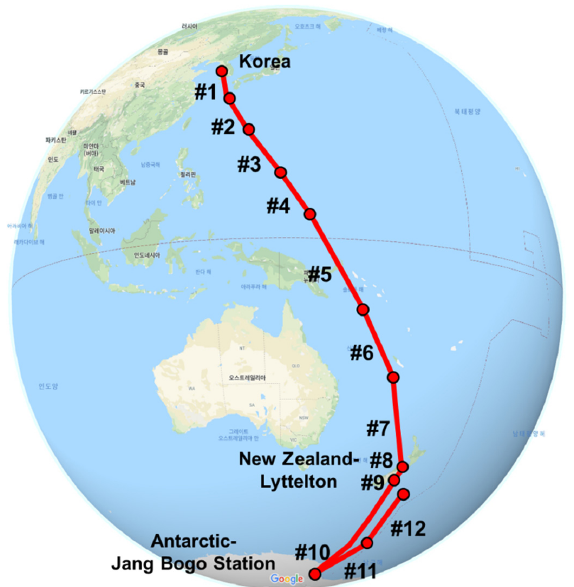
Figure 1. Sampling route taken by the Ice Breaking Research Vessel (IBRV) Araon from Incheon to the Antarctic Jang Bogo Station for the period of 2018.10.31 to 2018.12.14 (Map data: © 2020 Google, ORION-ME). Table 3. Sampling information, including sampling time, location, volume, and route.